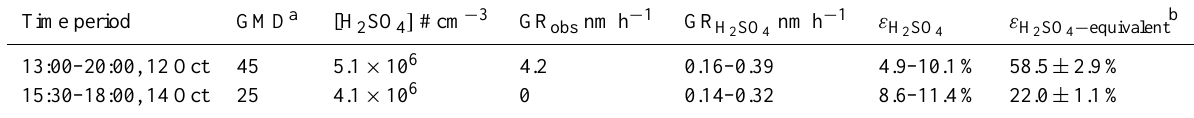
Table 2. The observed and calculated growth rate.